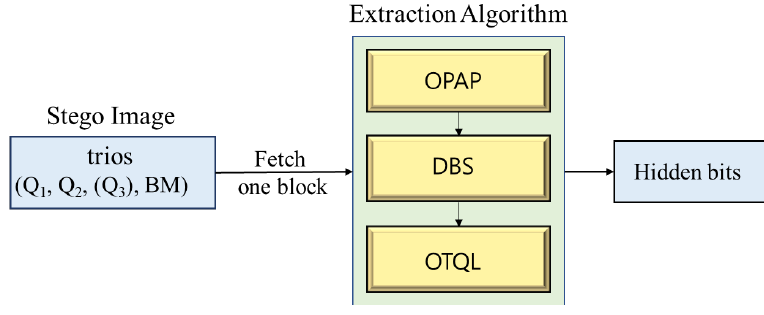
Figure 2. Schematic of the extraction